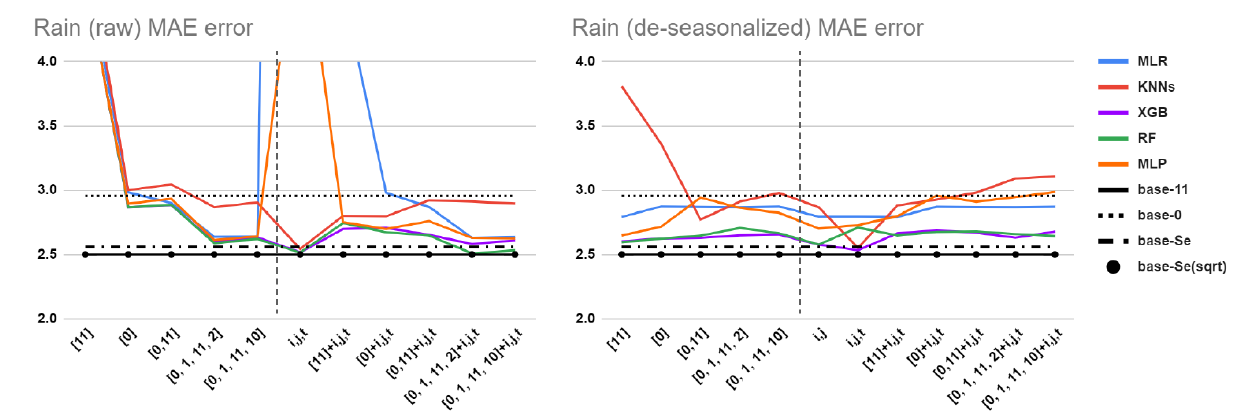
Figure 7. MAE for rainfall predictions with different feature sets, for raw and de-seasonalized data sets.